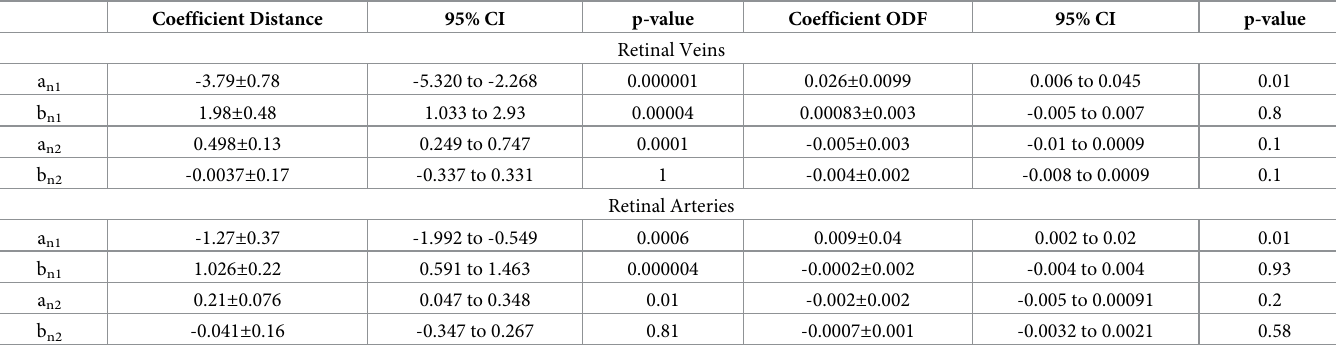
Table 3. Linear mixed effects model of the individual coefficients of the Fourier trigonometric series from the first and second harmonics.